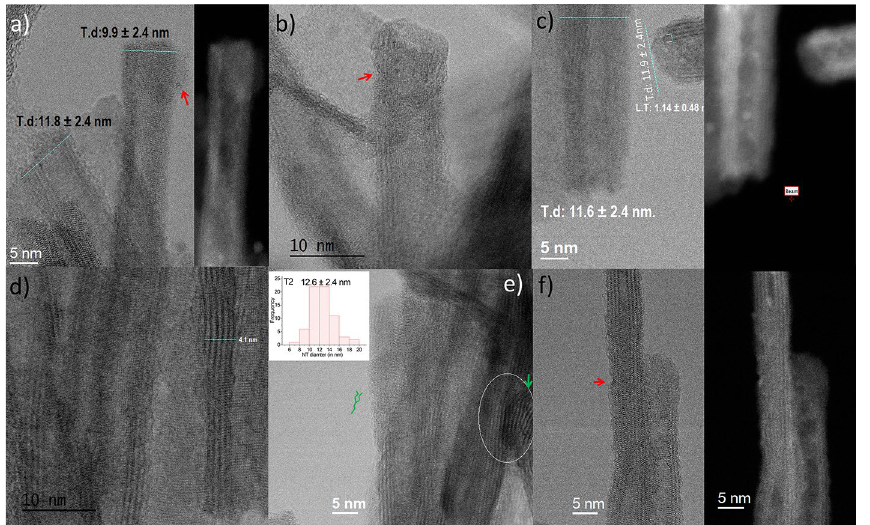
Figure 5. STEM micrographs of T2 showing the widening and waveform of nanotubes (NTs) obtained at 60 kV in Nion Ultra STEM 100MC ’HERMES’ ( a , c , f ) bright field (BF) vs High-angle annular dark-field (HAADF) inset. ( b , d , e ) BF micrographs. Fracture (red) and dislocation